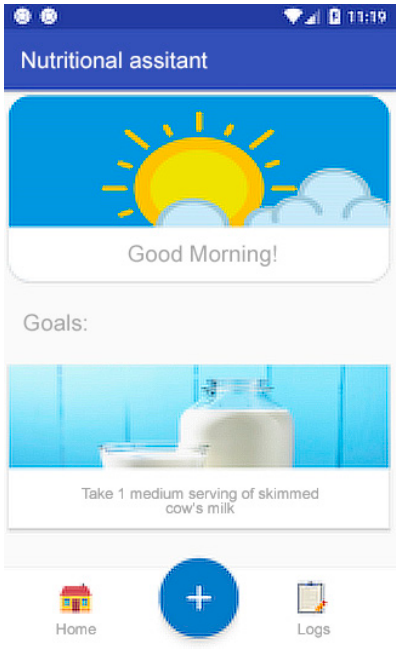
Figure 7. Welcome screen and display of outstanding goals.